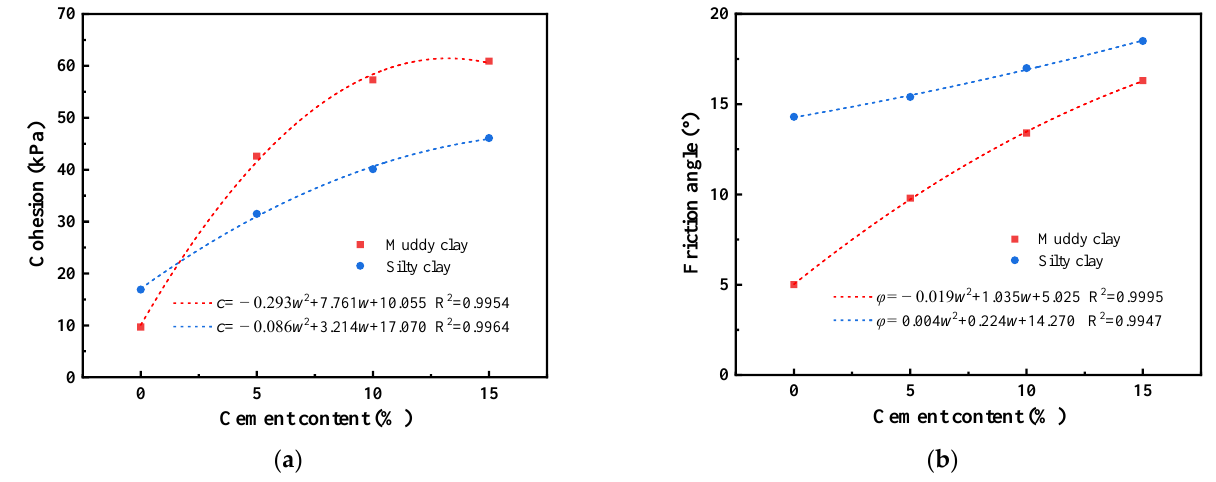
Figure 8. Variation in shear strength index with cement content. ( a ) Cohesion. ( b ) Friction